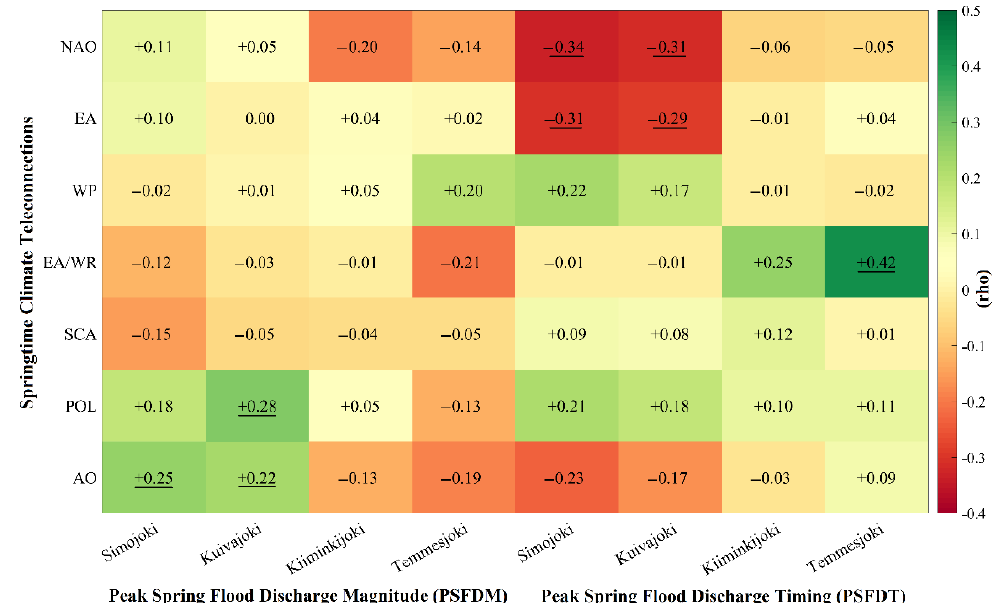
Figure 4. The Spearman’s rank correlations (rho) of springtime climate teleconnections with peak spring flood discharge magnitude (PSFDM) and timing (PSFDT) in all the Simojoki, Kuivajoki, Kiiminkijoki, and Temmesjoki rivers across northern Finland during 1967 – 2011. The underlined values show statistically significant ( p < 0.05) correlations.